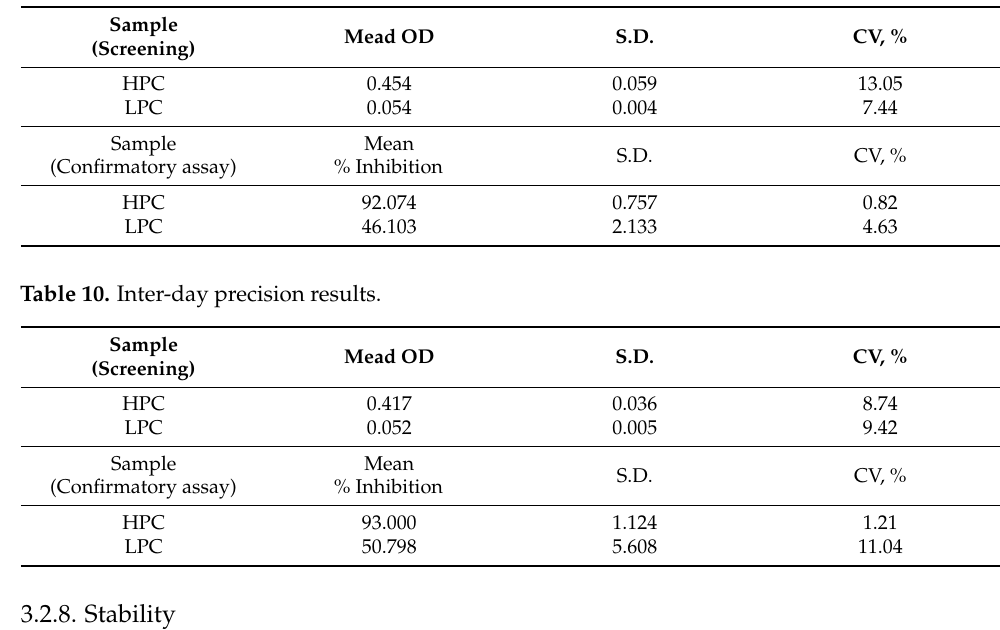
Table 9. Intra-day precision results.